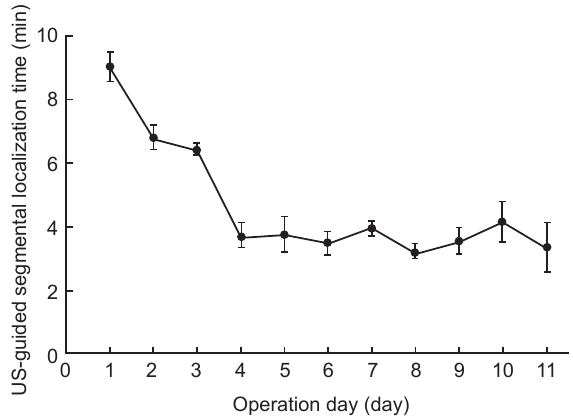
Figure 5 The learning curve for US-guided segmental localization of lumbar